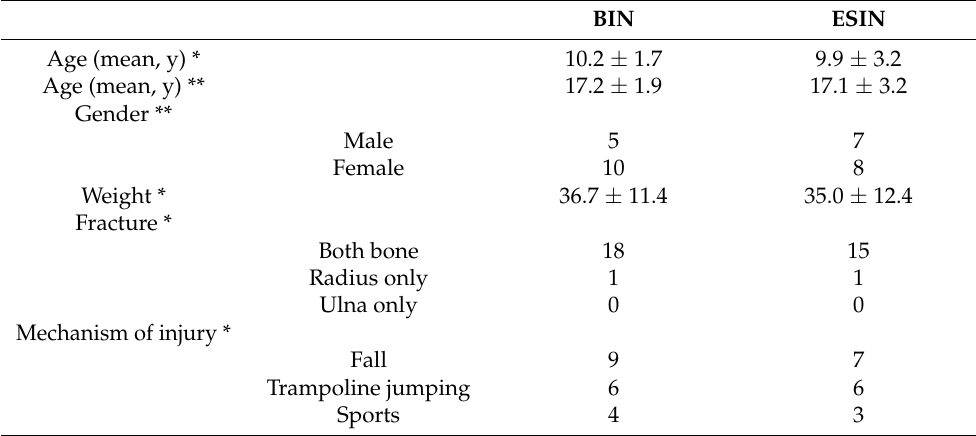
Table 1. Patient and Injury